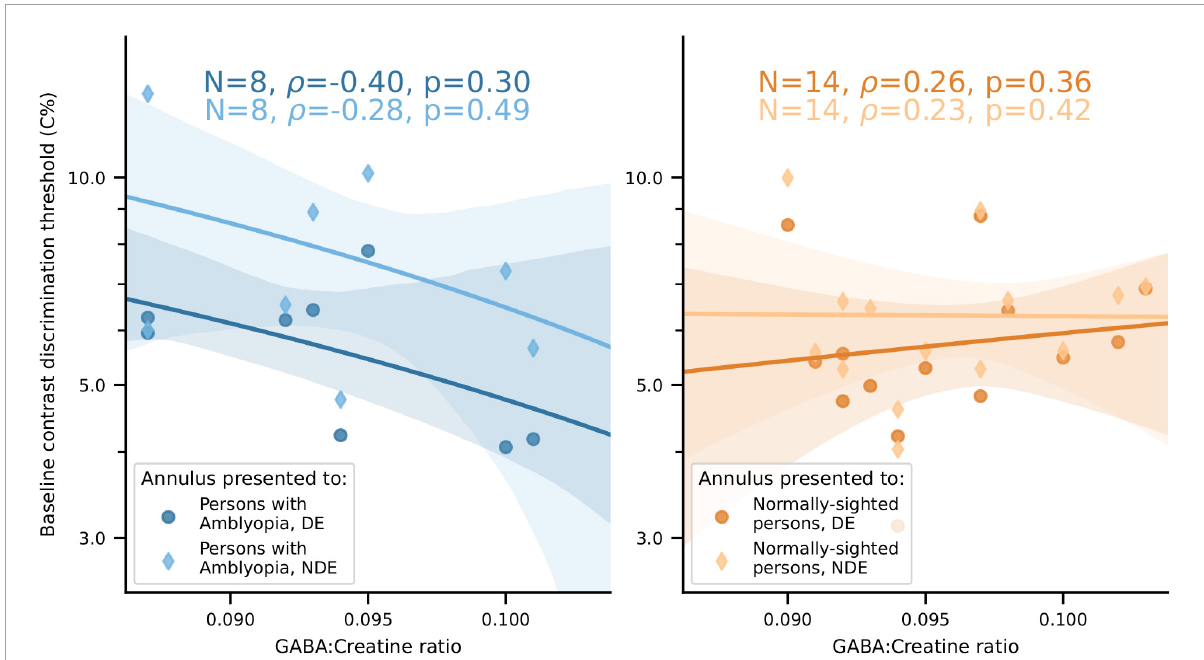
FIGURE11 No significant relationship between visual cortical GABA levels and baseline contrast discrimination thresholds for either PWA or NSP. Left, PWA. Right, NSP. Marker shape and color indicate the eye that viewed the annulus. Shaded regions are bootstrapped 95% confidence intervals of the best linear